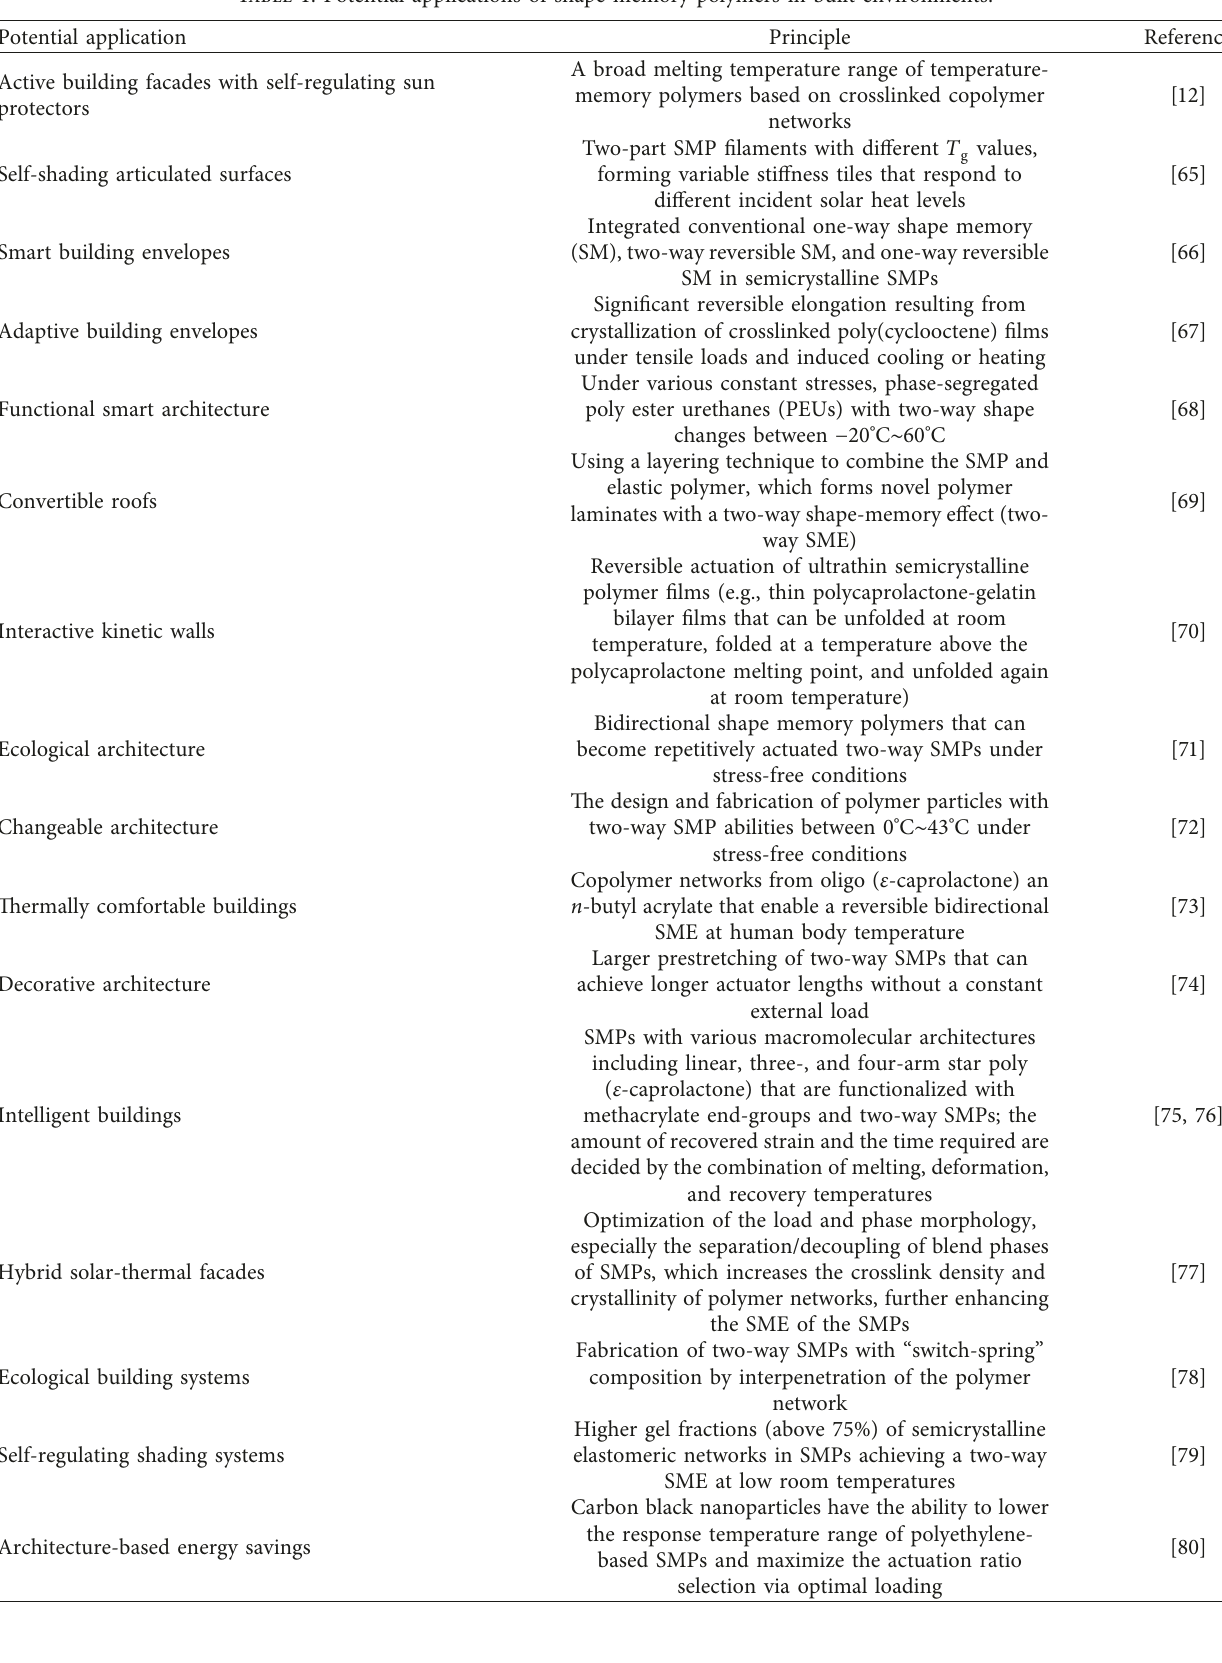
Table 1: Potential applications of shape memory polymers in built